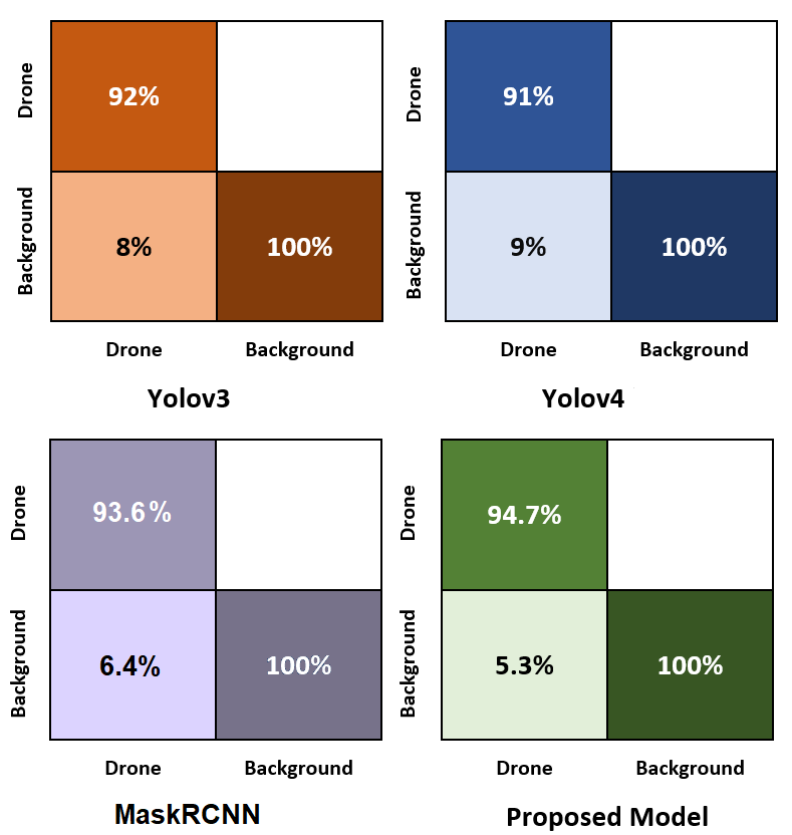
Figure 15. The precision of drone detection using the proposed model and other competing models namely: Yolov3 [32], Yolov4 [33], and MaskRCNN [44].